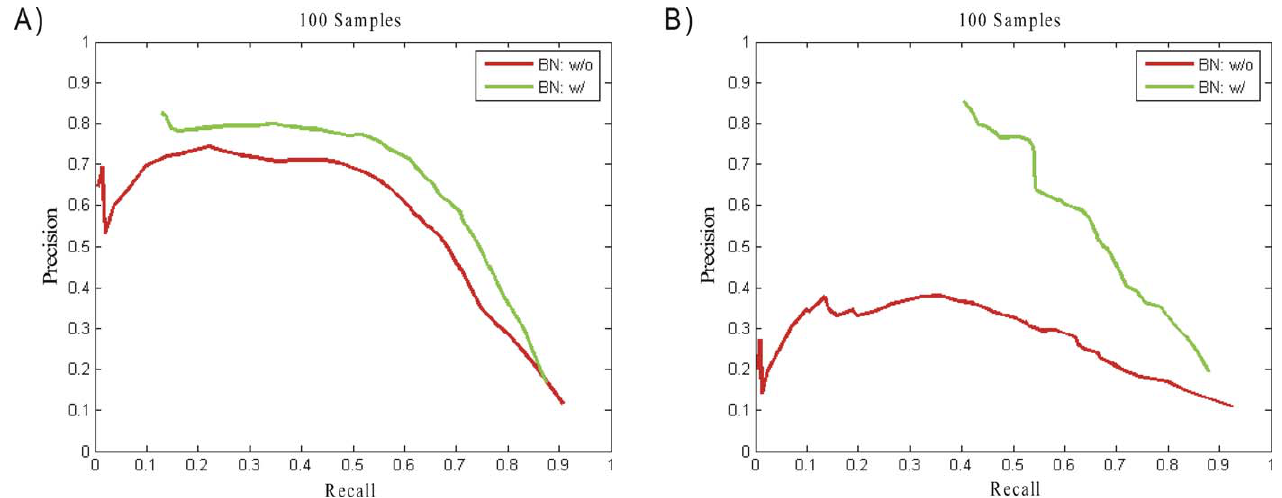
Figure 2. Reconstruction Accuracy Based on 100-Sample Datasets Generated Using Parameters Similar to BXD Data All accuracies are based on directed graphs unless indicated otherwise. (A) Accuracy of reconstructions with and without genetic information used as prior information. (B) Accuracy of reconstructions for the top-layer subnetwork, as defined in the text.